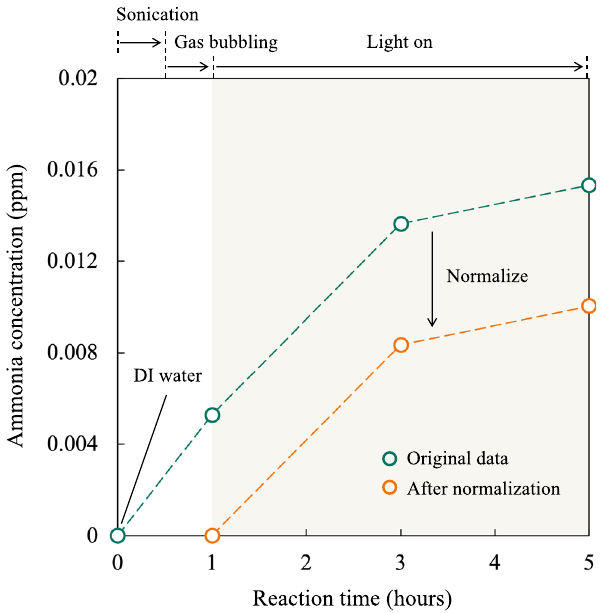
Fig.2|Activityofcommercialp25titaniumdioxide. Theammoniaconcentration versustime(beforeandafternormalization).Theexperimentisoperatedunderthe full